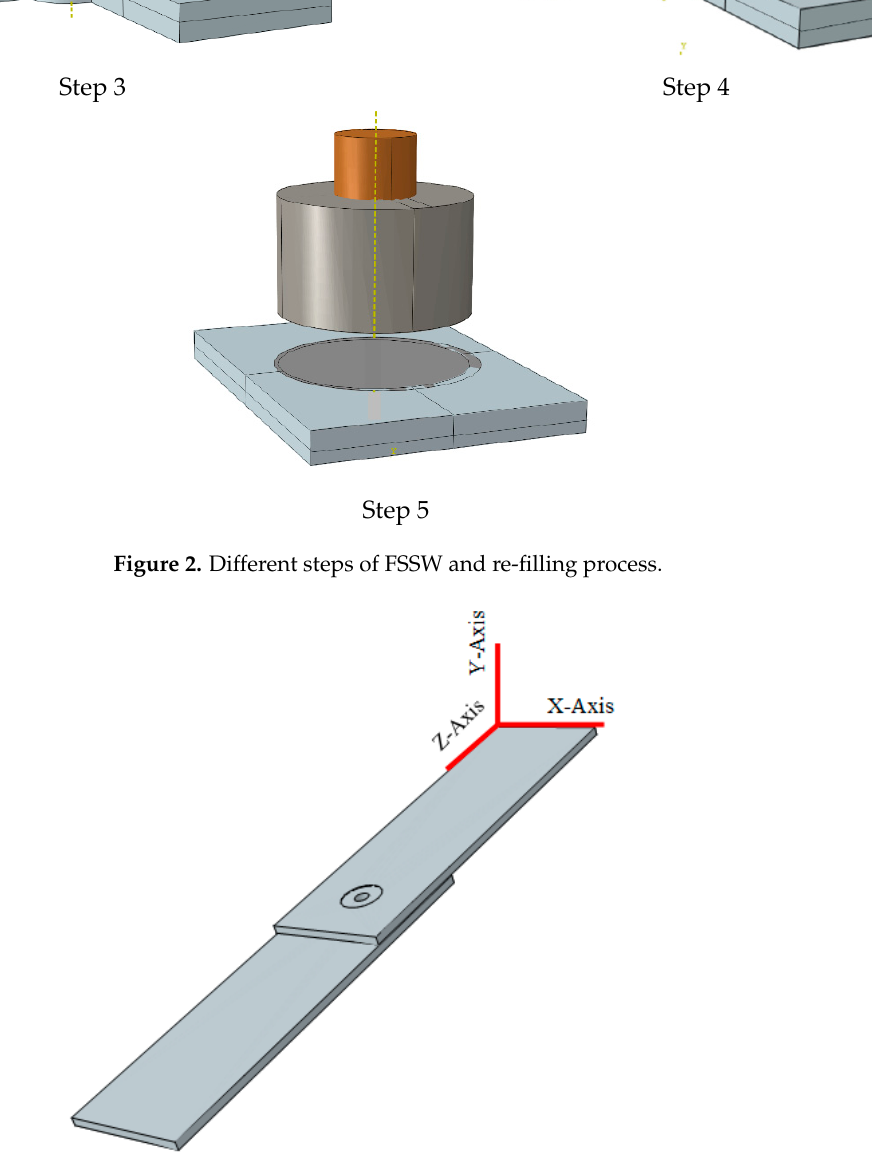
Figure 4. An example of a meshed plate with a probe hole. Table 2. Boundary conditions. Plane Simulation